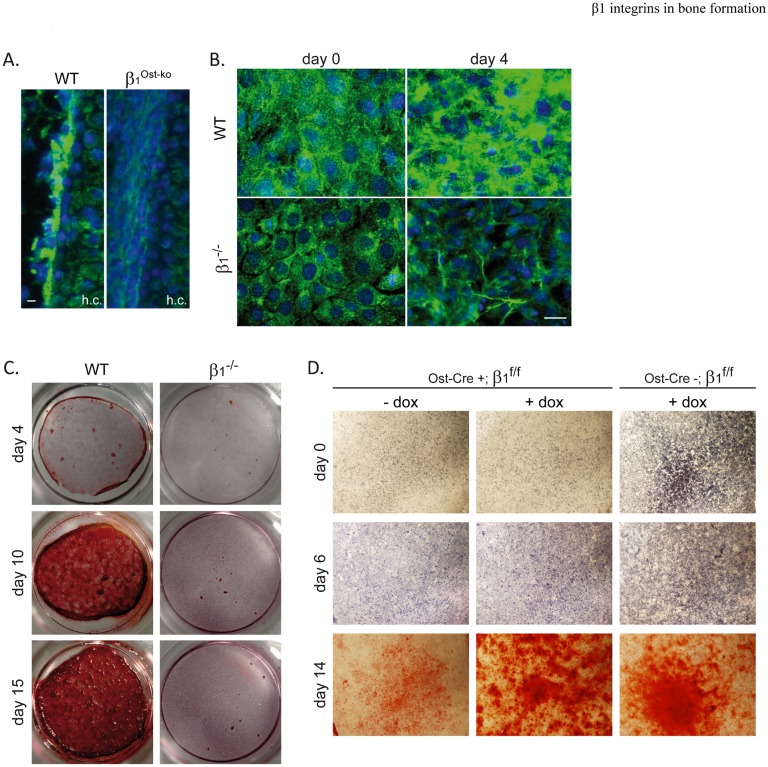
β1 integrins are necessary for Type I Collagen deposition and mineralization.A. Immunofluorescence analysis of Type I Collagen deposition on wild-type and β1Ost-ko E14.5 embryos femur sections (h.c.: hypertrophic cartilage; scale bar represents 10μm). Note that Type I Collagen deposition onto β1Ost-ko developing bones surface was almost absent. B. Immunofluorescence staining of Type I Collagen deposition by wild-type and β1 deleted (β1-/-) immortalized osteoblasts induced to differentiate for 4 days (day 4) or not (day 0)(Scale bar represent 10μm). C. and D. Mineralization capability, visualized by Alizarin red staining, of WT vs β1-/-, and Ost-Cre expressing β1f/f vs control (Ost-Cre negative) immortalized osteoblasts induced to differentiate for 4, 10 or 15 days (C.) or 0, 6 and 14 days (D.). Doxycycline was added to the medium (+dox) to block Cre expression. Note the lack of mineralization of β1-/- and Ost-Cre+;β1f/f osteoblasts cultures and the mineralization rescued in presence of doxycycline.